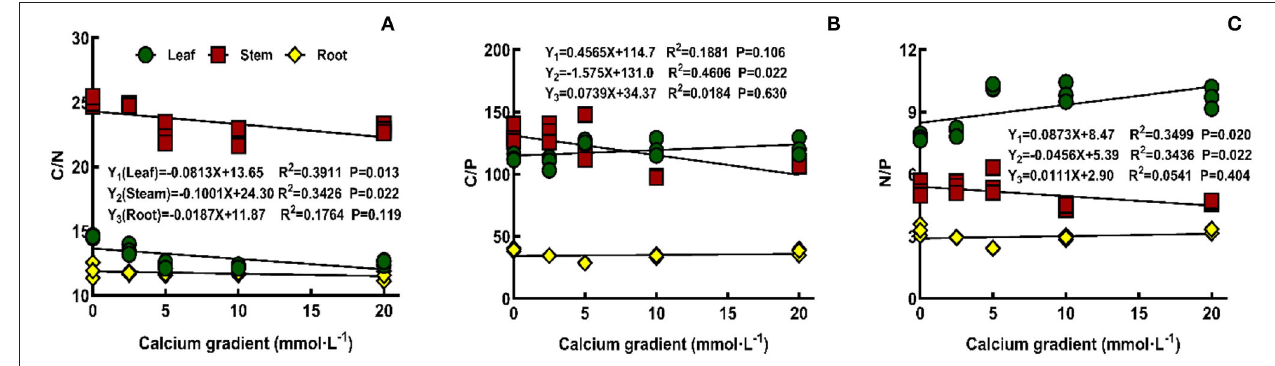
FIGURE 7 | Effect of calcium on C/N, C/P, and N/P ratios of poplar